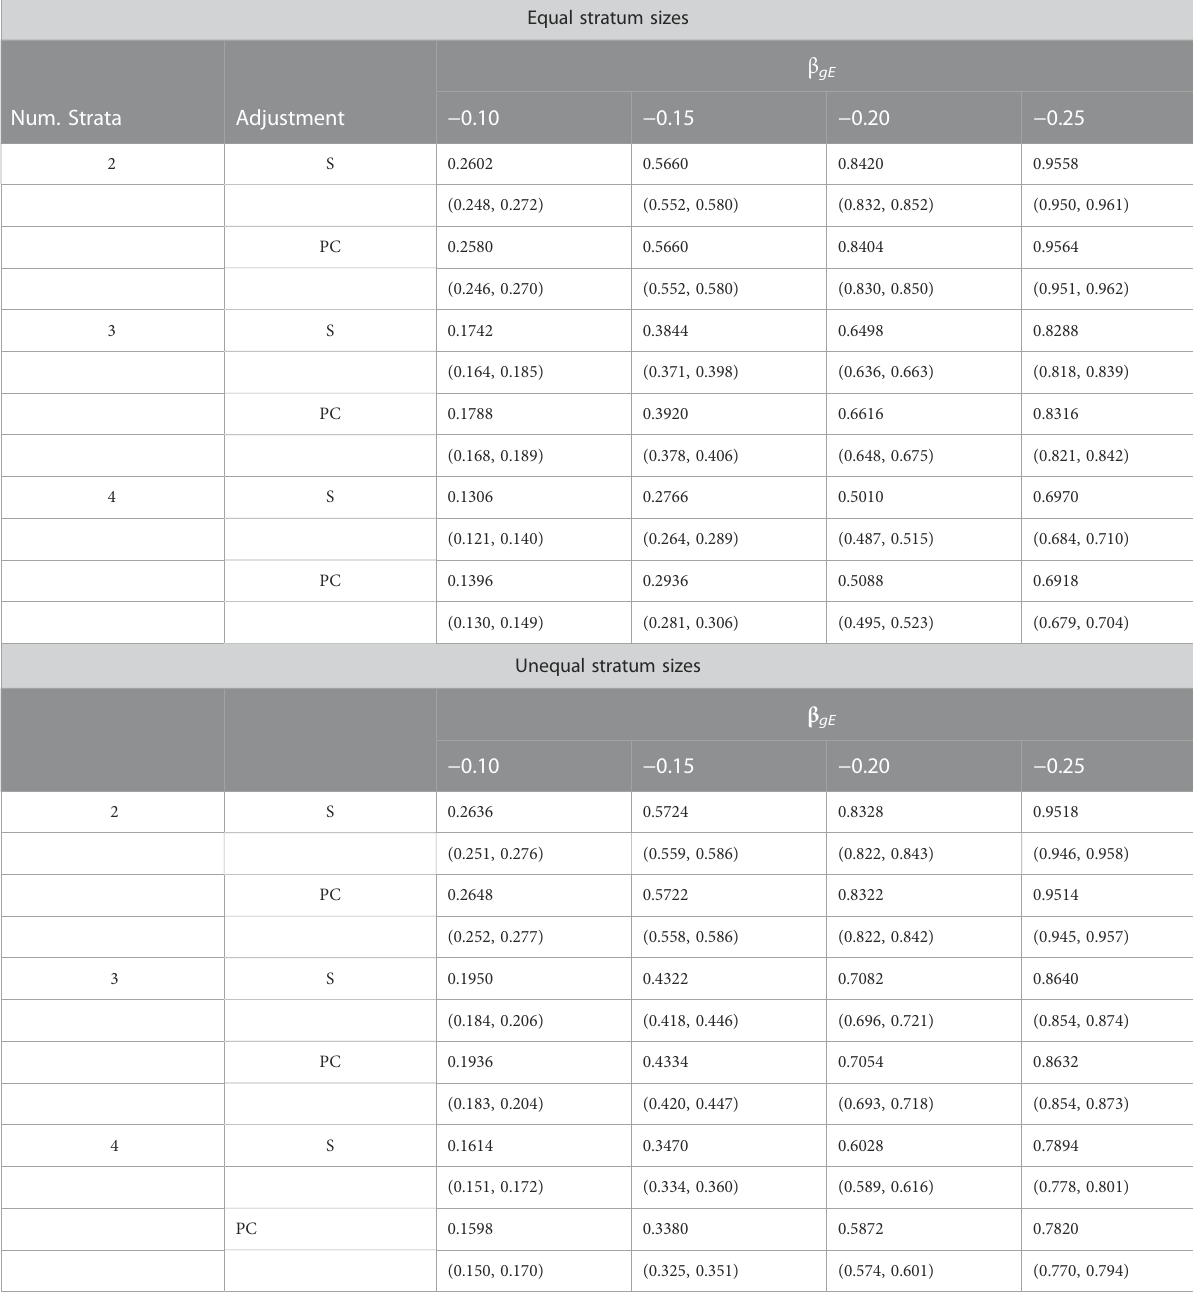
Equal stratum sizes β gE